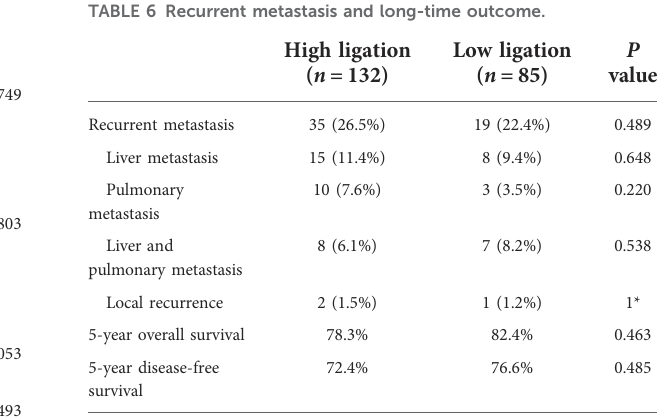
TABLE 6 Recurrent metastasis and long-time outcome.